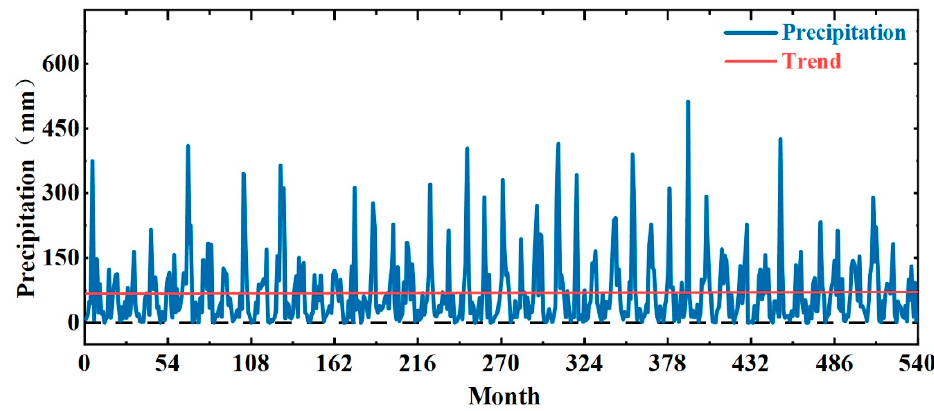
Figure 5. Month-by-month precipitation data for Zhoukou City, 1978–2022.